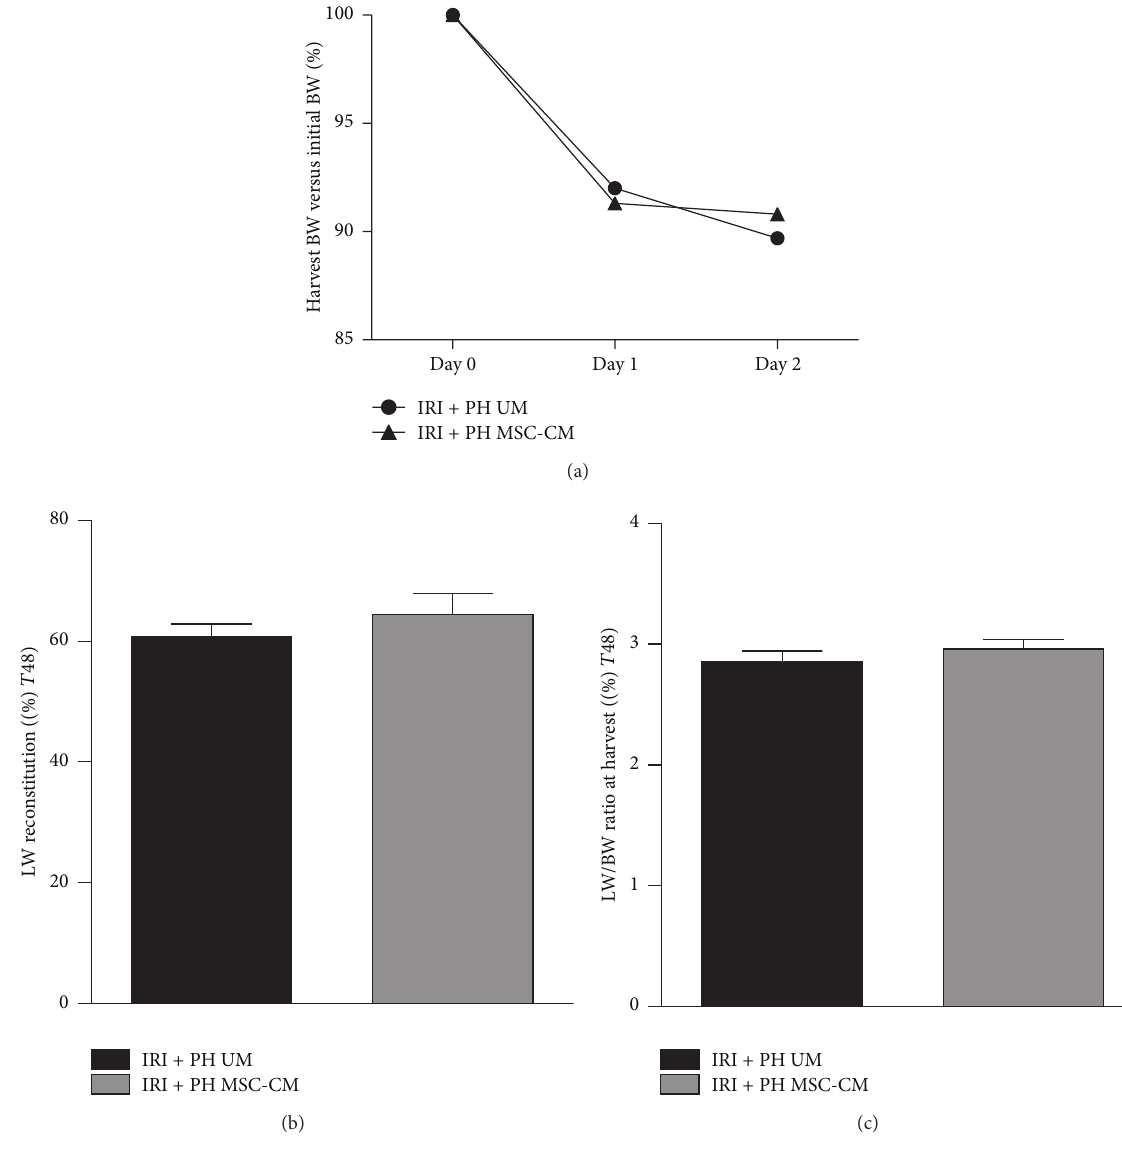
Figure 1: Effects of MSC-CM on body and liver weight after IRI + PH. (a) Body weight change from surgery to harvest; (b) harvest liver weight versus initial liver weight; (c) harvest liver weight to body weight